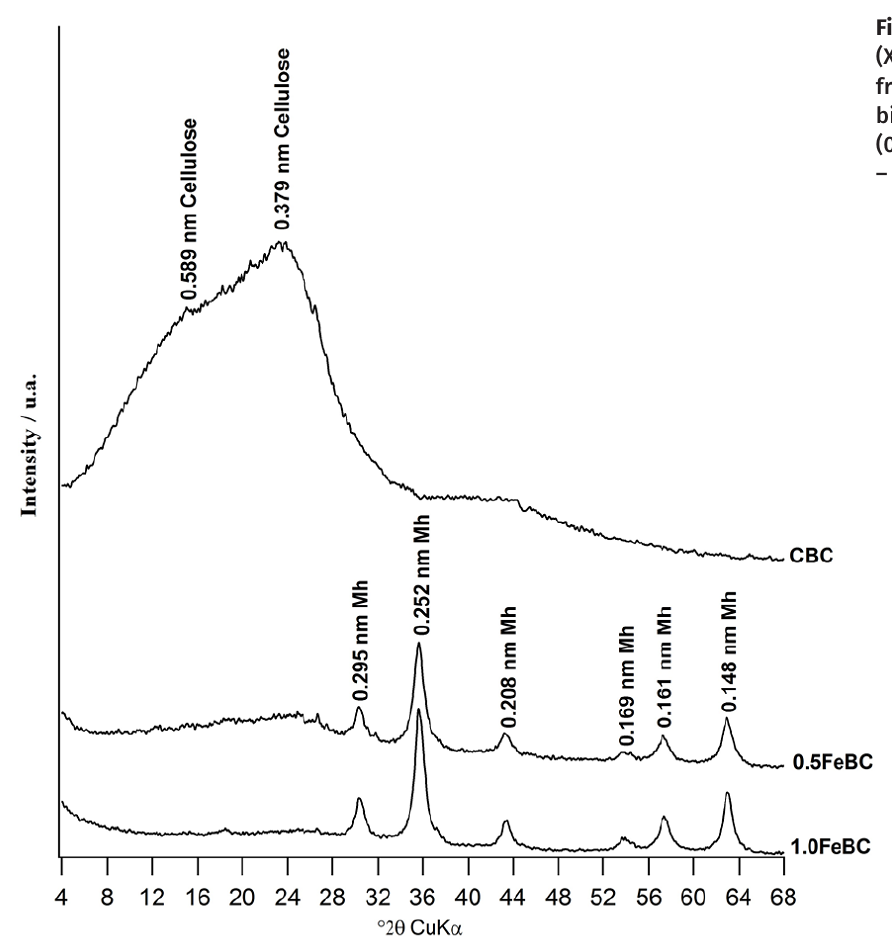
Figure 2. X-ray diffraction (XRD) pattern collected from biochar (CBC) and O composite biochar/γ-Fe 2 3 (0.5FeBC and 1.0FeBC). Mh –